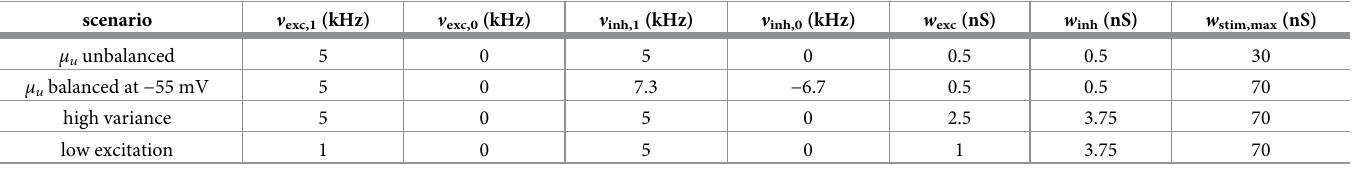
Table 4. Background input parameters for the different conductance-based input scenarios.